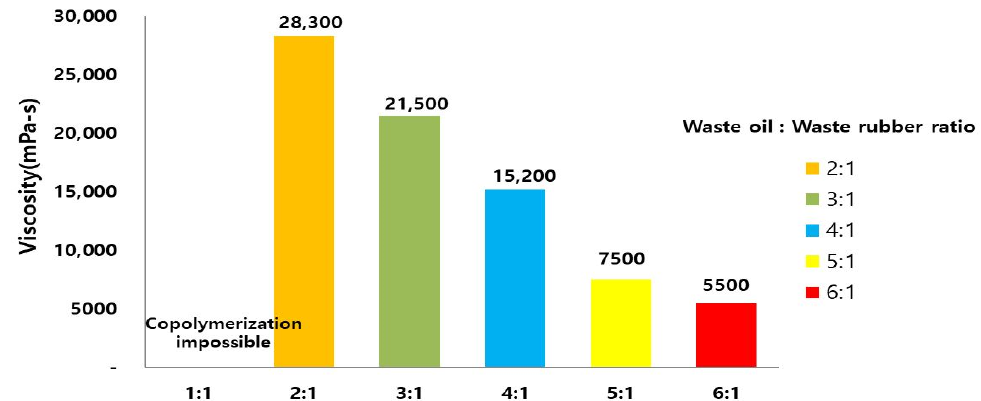
Figure 7. Viscosity value with ratio of waste oil and waste